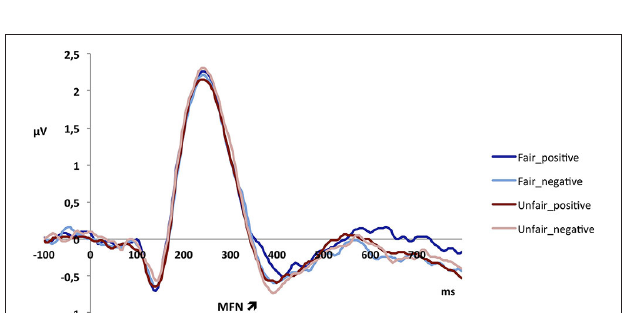
FIGURE 3 | Electrophysiological data shows that offers presented in the certain context elicit a more negative MFN than those presented in the uncertain